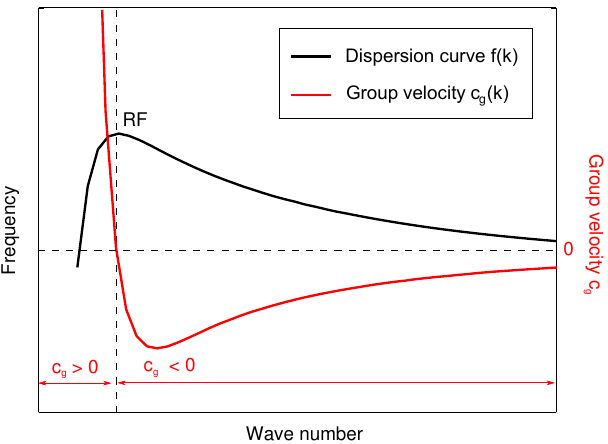
Figure 2. Illustration of a typical mode 1 CTW dispersion curve (black line) with the corresponding group velocity (red line). For small wave numbers, the group velocity is positive, while it be- comes negative for larger wave numbers, i.e. indicating a change of direction of energy propagation. At the maximum of the disper- sion curve (the resonant frequency, RF), the group velocity vanishes and energy is